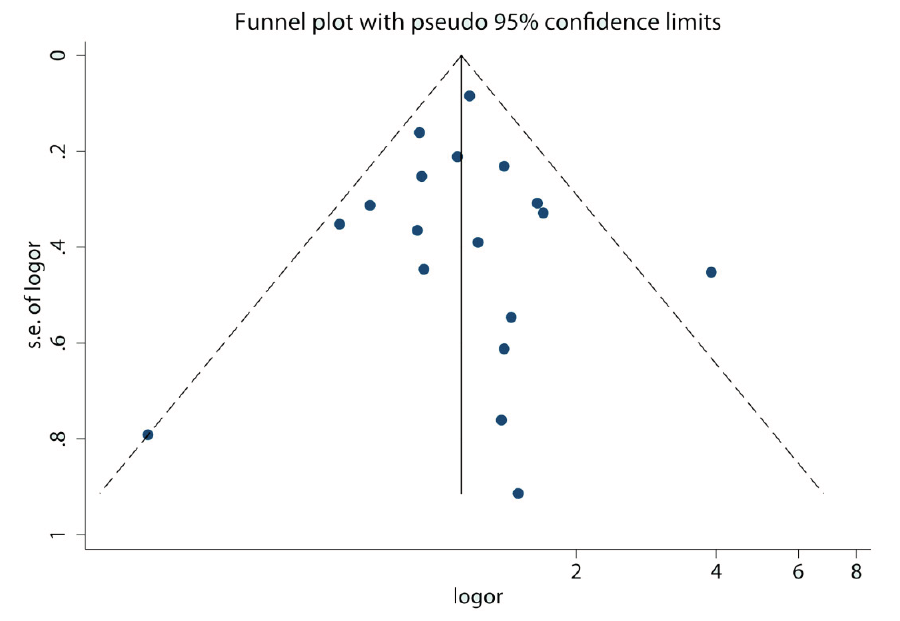
Figure 7. Funnel plot for studies on the relationship between high birth weight and bone tumor risk. The dashed lines are pseudo 95% confidence limits. The x-axis represents the OR on a logarithmic scale, while the y-axis points to the standard error of the OR on a logarithmic